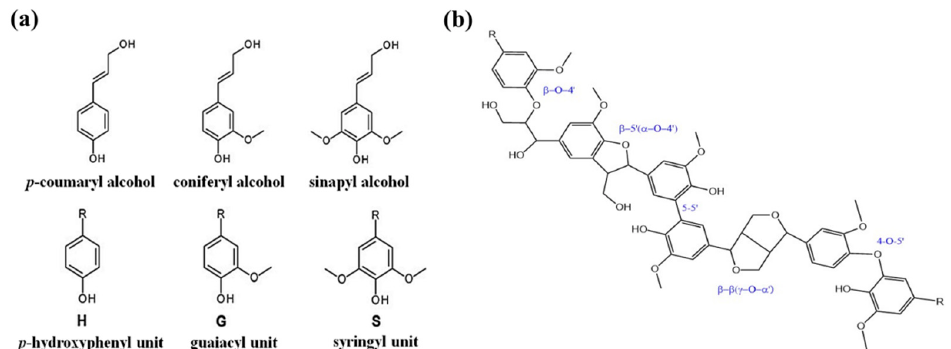
Figure 1. ( a ) Structures of monomeric precursors of lignin; the monolignols H, G, and S (R = lignin); and ( b ) a model lignin featuring five G units connected by five common interunit linkages. Reprinted with permission from Ref. [21]. Copyright 2020 John Wiley & Sons.